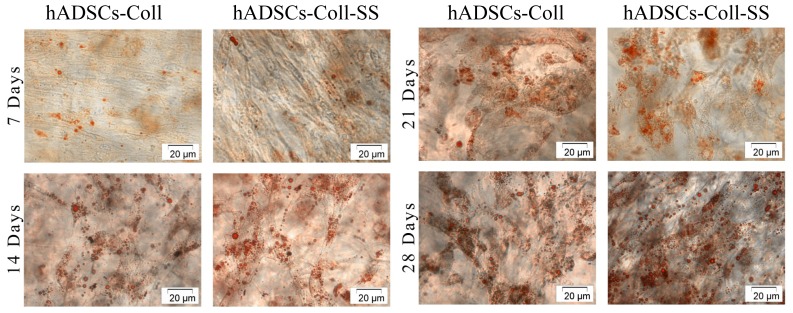
Contrast-phase micrographs of Oil Red O stained hADSCs-Coll and hADSCs-Coll-SS bioconstructs after 7, 14, 21 and 28 days post adipogenic induction.